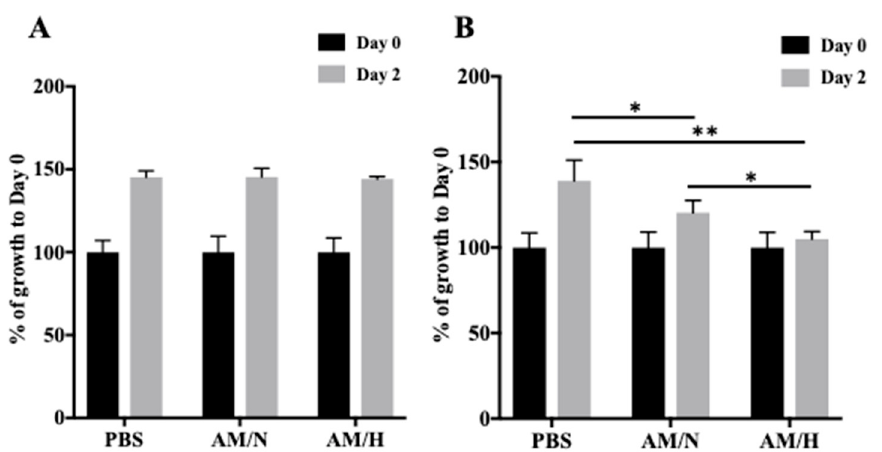
Figure 2. The effect of AM exosomes on the proliferation of LX-2 cells. LX-2 cells were activated with 4 ng/mL of TGF β -1 for 3 h. Exosomes isolated from AM under normoxic condition (AM/N) or exosomes isolated from AM under hypoxic condition (AM/H) at 5 μ g/mL were added to non-activated ( A ) or activated LX-2 cells ( B ) and incubated for 2 days. % of growth on Day 2 is expressed as % of increase in fluorescent intensity over that of Day 0. Data shown are mean ± SD ( n = 4). * p < 0.05 ** p < 0.01.